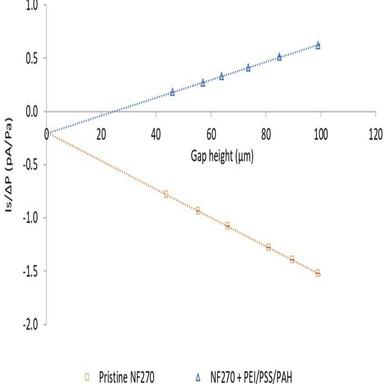
Streaming current coefficient (Is/ΔP) of the unmodified and PEI/PSS/PAH modified NF270 membranes versus gap height; Solution: 0.001 M KCl at pH 5.60 ± 0.05.